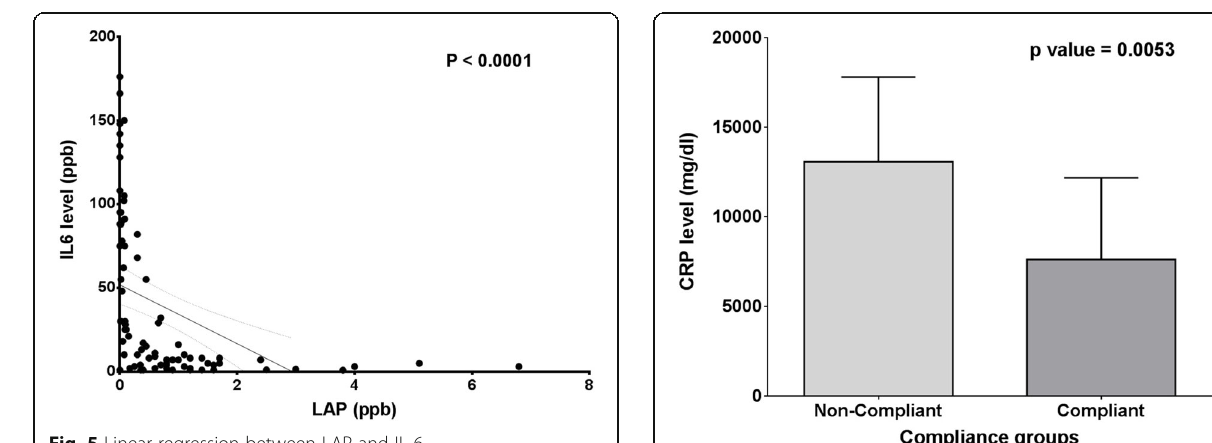
Fig. 5 Linear regression between LAP and IL-6